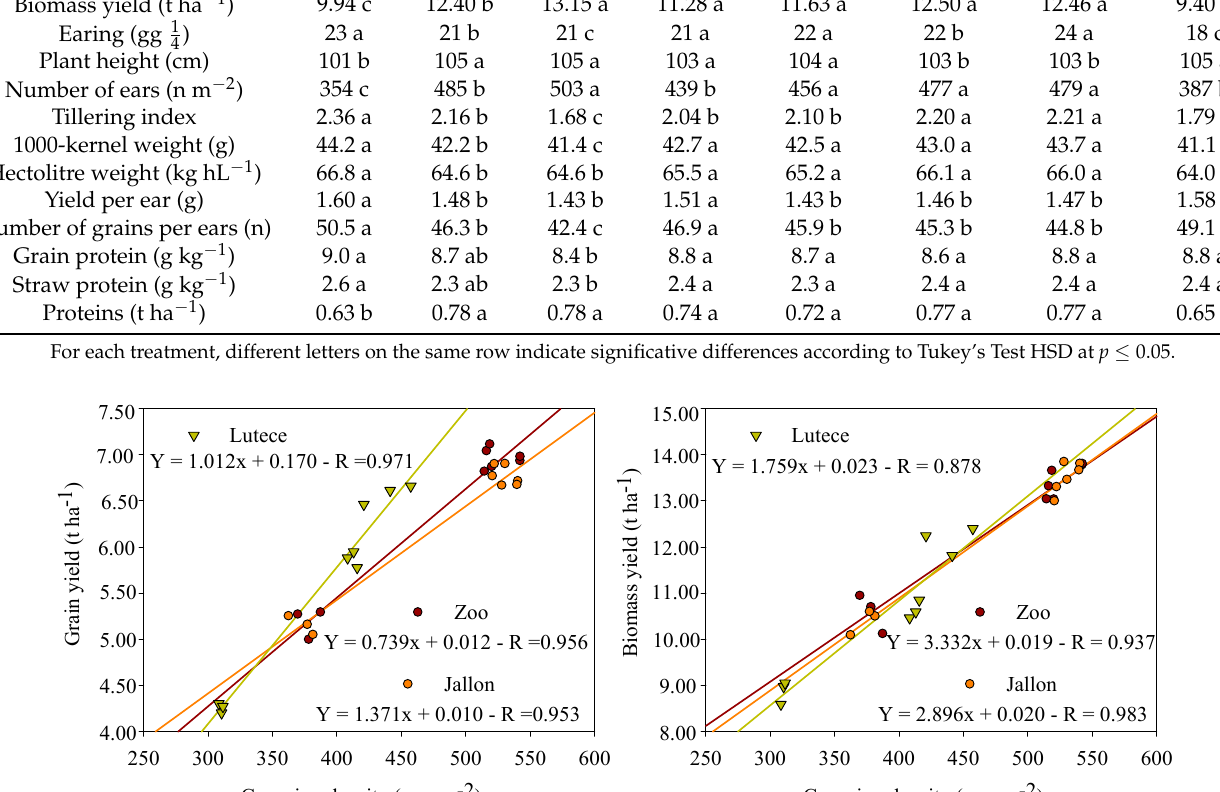
Table 4. Bio-agronomic behaviour of the genotypes under experiment in relation to treatments (fixed effects). Agronomic Traits